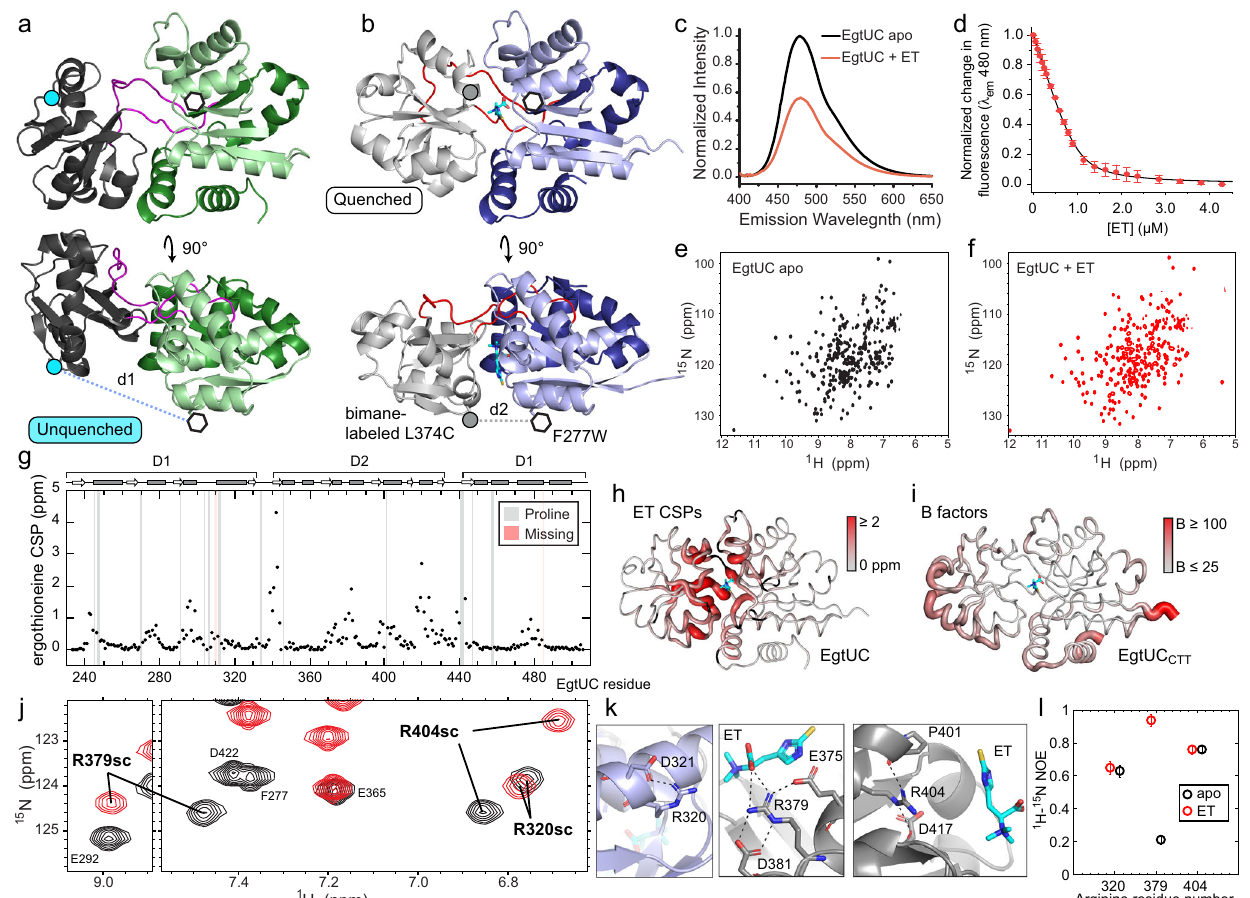
Fig. 4 | Conformational and dynamic changes in Sp EgtUC upon ET binding. a AlphaFold2 model of “ open ” apo Sp EgtUC (gray D2, green D1, magenta linkers). F277W and the L374C site of bimane labeling are shown asan open hexagon and a cyancircle,respectively. b The “ closed ” crystalstructureofET-boundSBD(grayD2, blue D1, red linkers), with F277W and L374C shown as in a . c Bimane fl uorescence emission spectra of bimane-labeled L374C/F277W Sp EgtUC with (red) and without (black)ET. d Normalizedchangein fl uorescenceemissionat480nmupontitration of bimane-labeled L374C/F277W Sp EgtUC with ET in a position-induced fl uores- cencequenching(PiFQ)experiment 51 .Eachtitrationpointisshownasthemeanand standarddeviationoftwoindependentreplicates.SeeTable1for fi ttedparameters. e 1 H, 15 N TROSY spectrum of apo EgtUC (residue-speci fi c assignments in Supple- mentary Fig. 12). f 1 H, 15 N TROSY spectrum of EgtUC bound to equimolar ET (Sup- plementary Fig. 13). g Backbone chemical shift perturbations (CSPs) upon binding